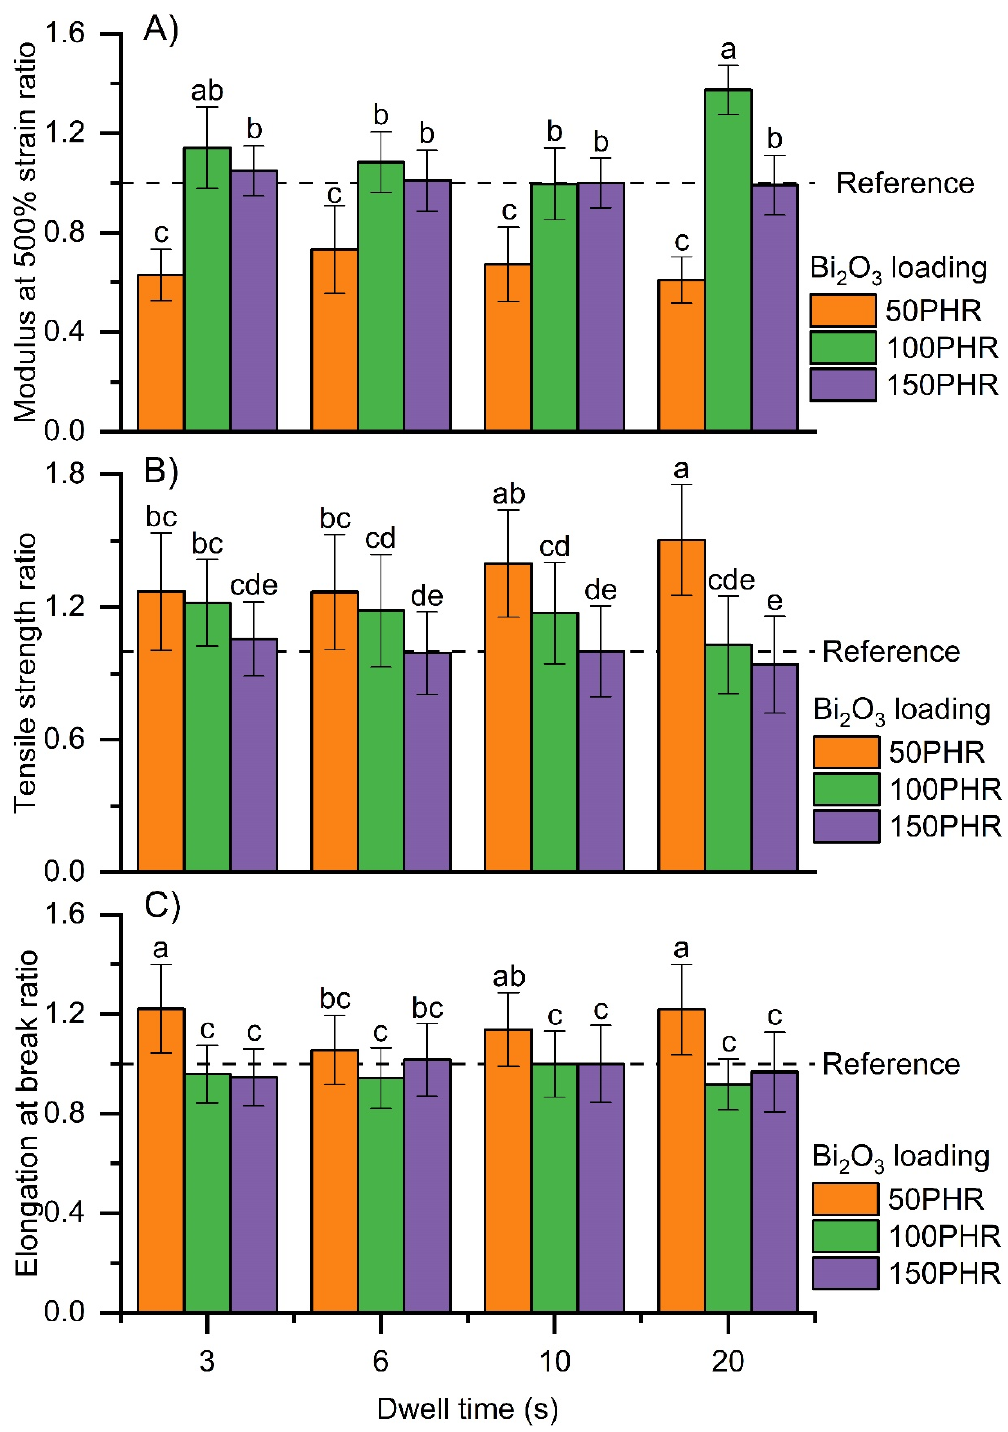
Figure 11. Effect of Bi 2 O 3 loading and dwell time on ratios of mechanical performance of dipped films versus reference films made with 150 PHR Bi 2 O 3 loading and cured at 90 ° C for 75 min. ( A ) Modulus at 500% strain ratio, ( B ) tensile strength ratio, and ( C ) elongation at break ratio of dipped films with 50, 100, and 150 PHR Bi 2 O 3 at dwell times of 3, 6, 10, and 20 s cured at 90 ° C for 75 min versus reference films made with 150 PHR Bi 2 O 3 loading. All films were cured at 90 ° C for 75 min. Results are expressed as means ( n = 10) ± 1 s.d. Films with statistically similar tensile properties are grouped together and marked with the same letter.